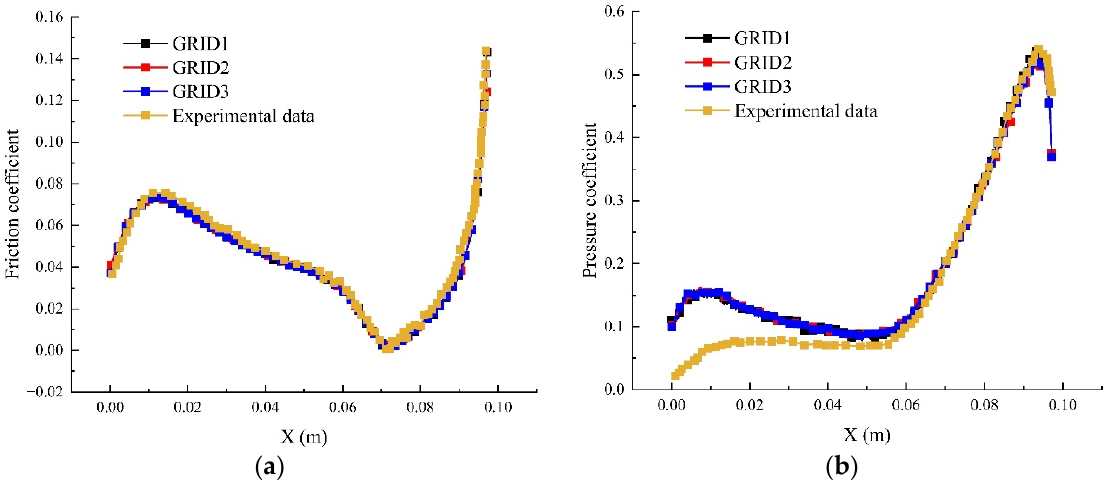
Figure 6. Wall coefficient distribution: ( a ) Friction coefficient; ( b ) Pressure coefficient.